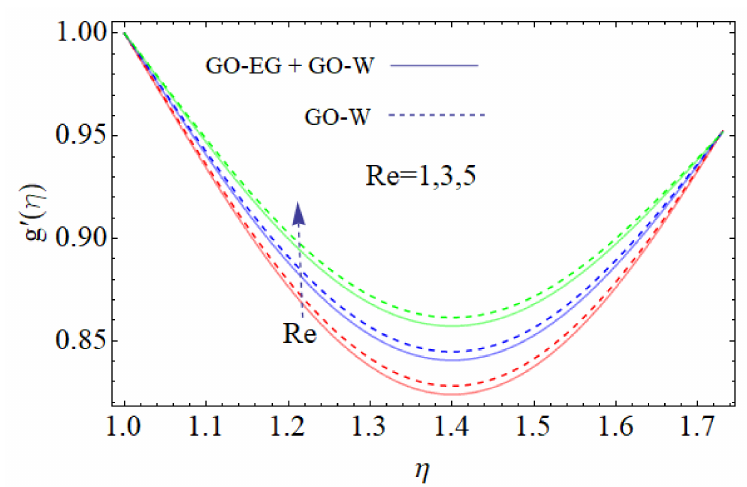
Figure 5. Influence of the Reynolds number on the velocity